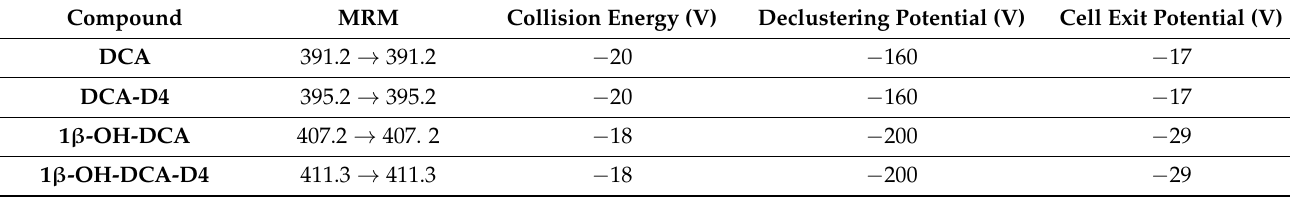
Table 1. LC–MS/MS settings for the analytes and their respective internal standards